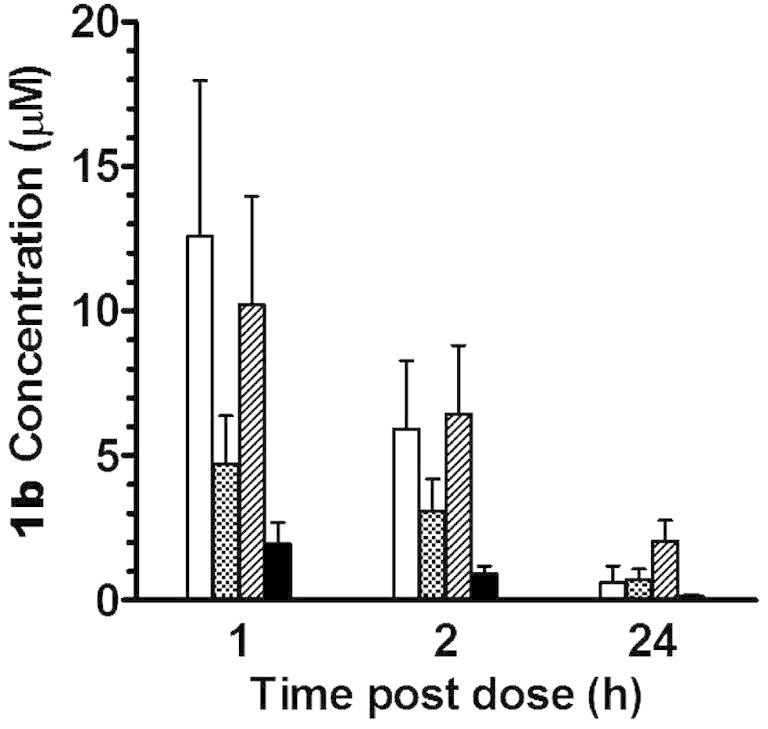
Concentration of 1b in liver (), spleen (), kidney (), and plasma () after oral administration at a dose of 100 μmol/kg (or 40 mg/kg) to mice. Bars and error bars represent means and standard errors of triplicate determinations, respectively.